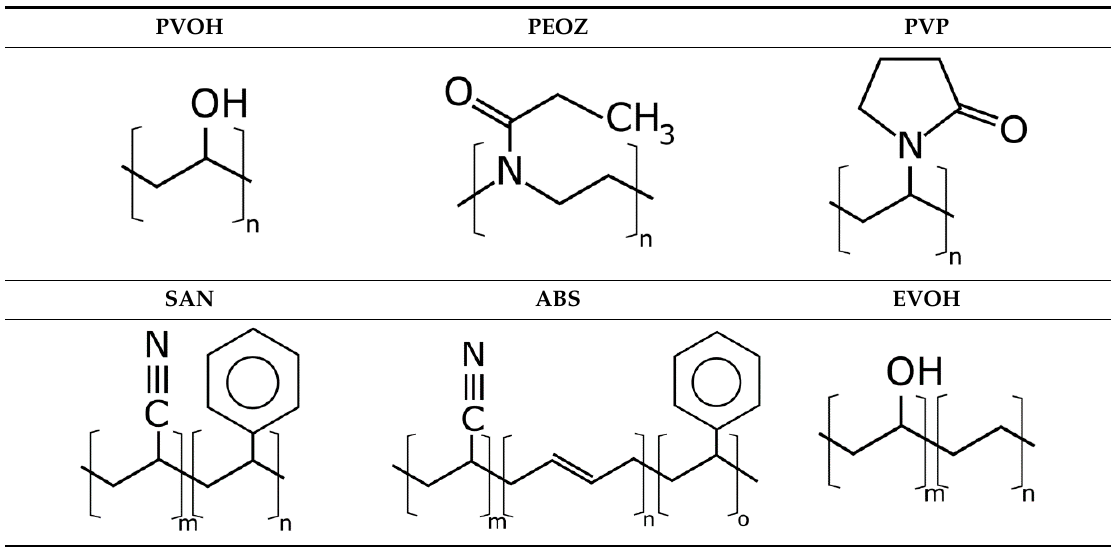
Table 2. Structural formulas.